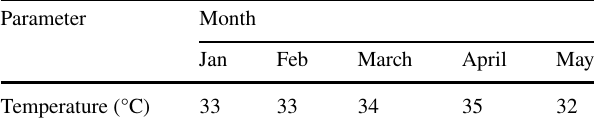
Fig. 1 a Layout of the existing NITK treatment plant, b layout of the proposed pilot-scale HSSF-CW and